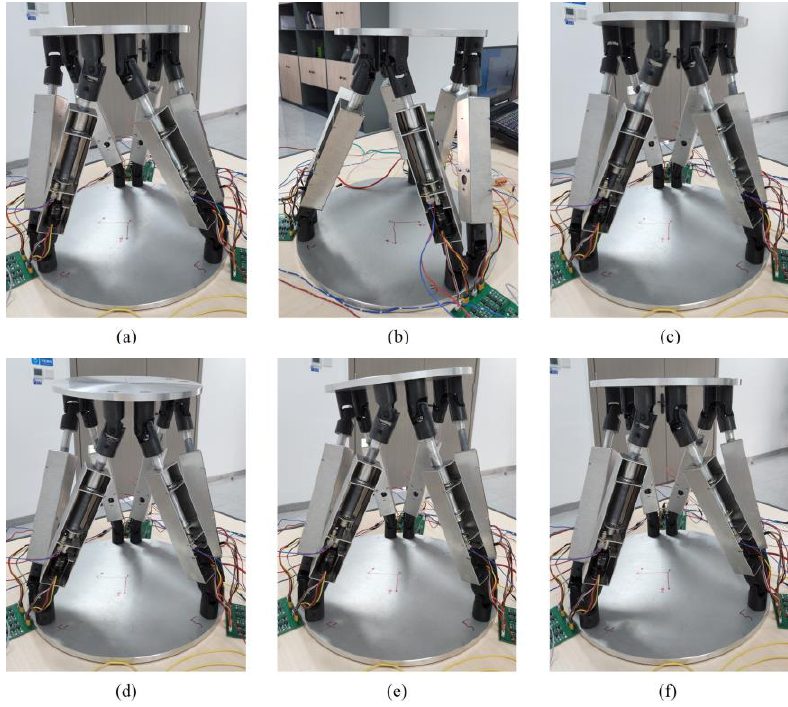
Figure 26. Six degrees of freedom attitude closed-loop control of the parallel platform; ( a ) translate along the x -axis; ( b ) translate along the y -axis; ( c ) translate along the z -axis; ( d ) rotate along the x -axis; ( e ) rotate along the y -axis; ( f ) rotate along the z -axis.